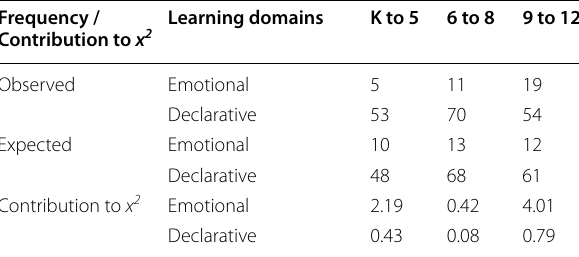
Table 4 Observed and expected frequencies of the emotional domain across grade bands Frequency / Contribution to x 2